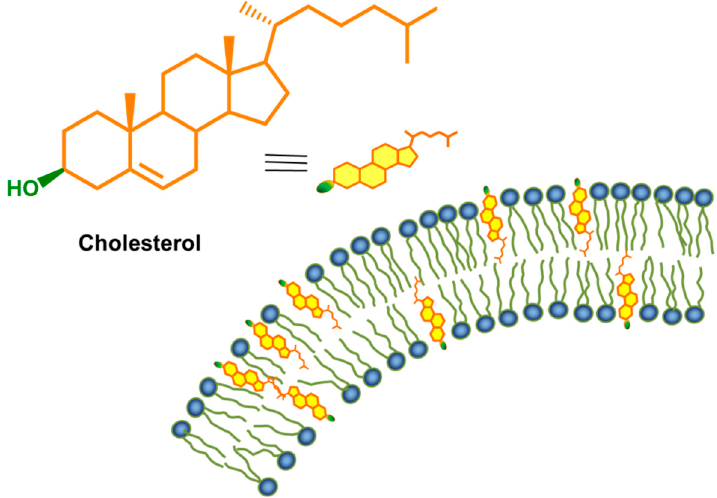
Figure 1. The structural formula of cholesterol and interaction in lipid bilayer.